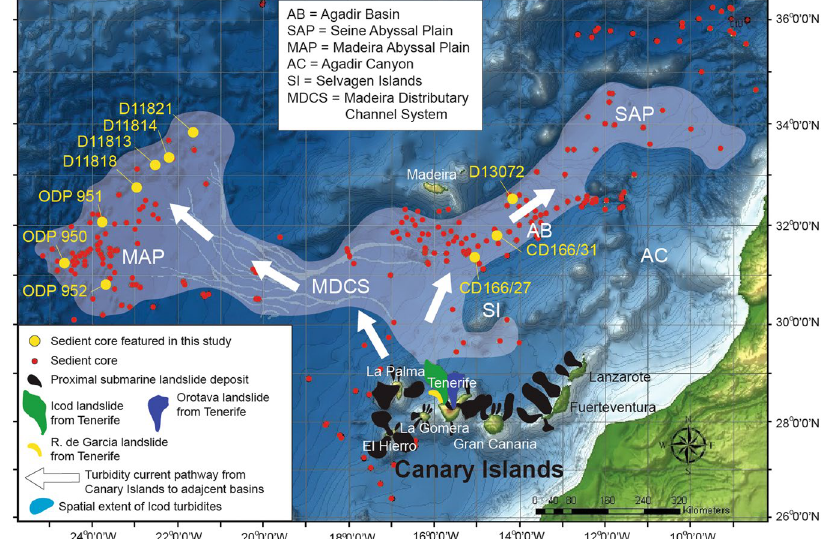
Figure 1. Map of the Canary Islands and the Moroccan Turbidite System. Canary Islands debris avalanche deposits shown in black, while Icod deposit is in dark green, the Orotava deposit in dark blue, Roques de Garcia in red, and Cumbre Neuva in yellow. Pale overlay signifies the spatial distribution of the sediment gravity flow deposits associated with the Icod landslide from Northern Tenerife. Sediment core locations are shown as red circles, while cores referenced in this contribution are in yellow and labelled (including ODP Sites 950, 951 and 952). Abbreviations are: AC = Agadir Canyon, AB = Agadir Basin, MAP = Madeira Abyssal Plain, SAP = Seine Abyssal Plain, MDCS = Madeira Distributary Channels, and CBR = Casablanca Ridge. Canary Islands landslides Icod (brown), Orotava (purple) and Rogues de Garcia (red) from Tenerife and Cumbre Nueva (grey). May also shows the area extent of the turbidites associated with the Icod landslide. Map was generated using ArcGIS 10.1 software based upon bathymetric and digital elevation data from GEBCO